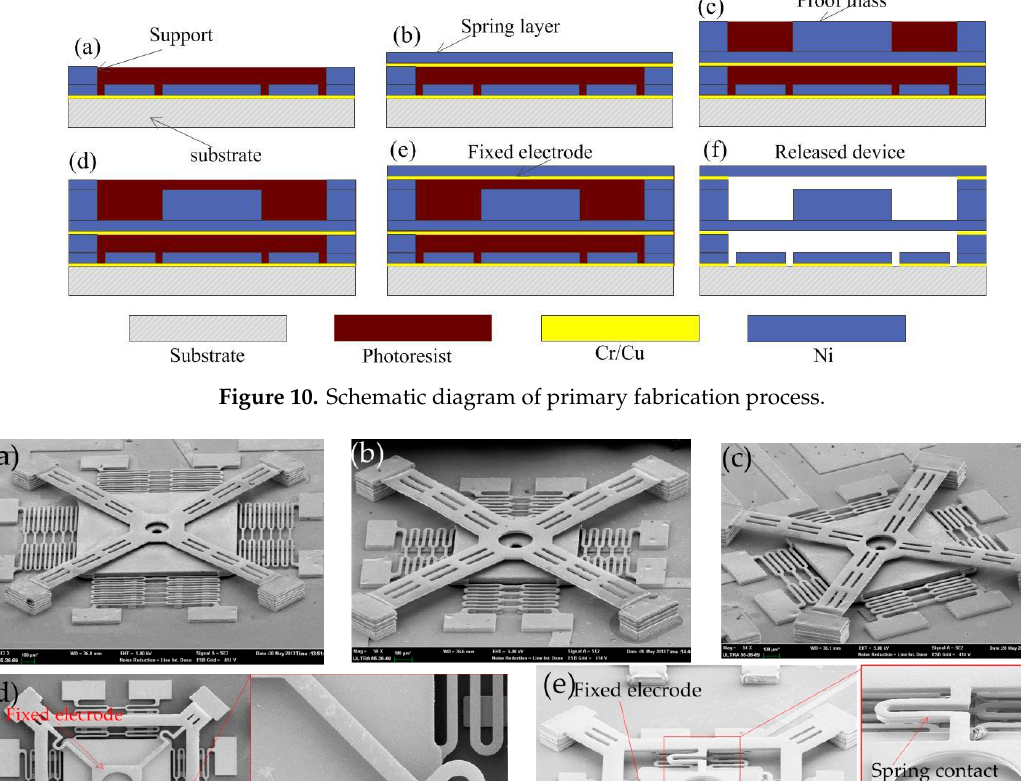
Figure 13. Tested results of prototypes with different thresholds. ( a ) 20, ( b ) 295, ( c ) 580, ( d ) 305, and ( e ) 580 g, and ( f ) curves of the threshold, contact time, and response time.